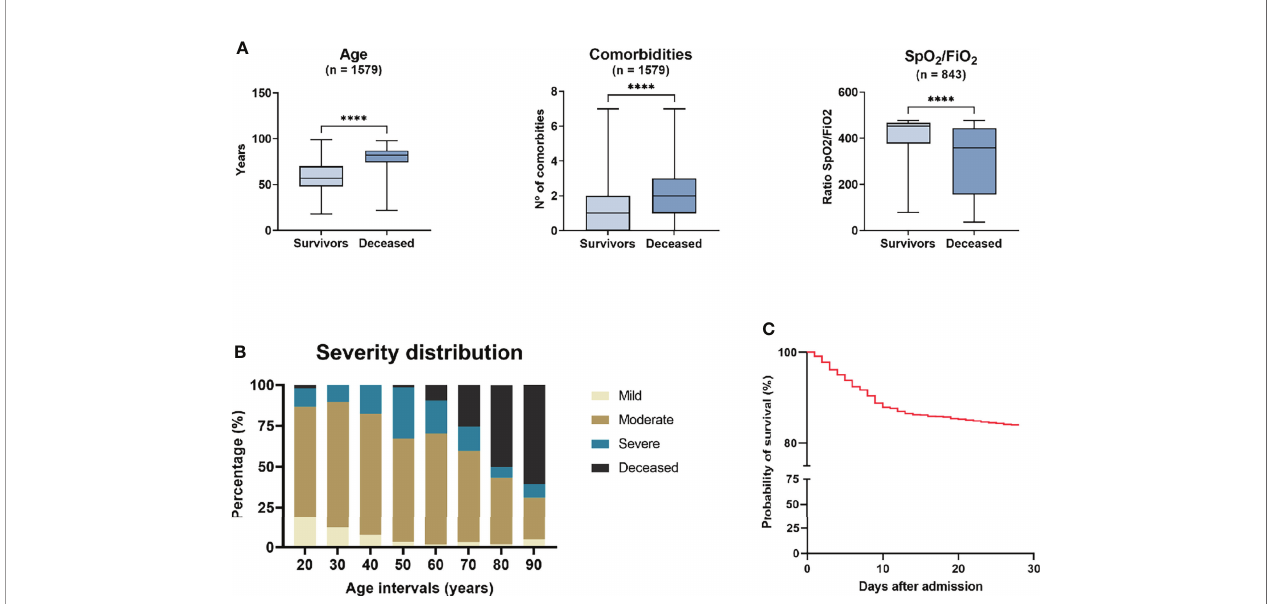
FIGURE 2 | The structure and outcomes of the Vall d ’ Hebron University Hospital cohort. (A) Left panel, age distribution of the survivors and that of the deceased is markedly different (median [IQR]: 62 years [50 – 75 years] vs. 82 years [74 – 87 years], p<0.001) as are comorbidities (central panel) and SpO2/FiO2 (right panel). (B) Distribution of the patients in the HUVH cohort among the four severity categories, based on the World Health Organization criteria (described in the Material and Methods section). The number of patients in the mild category is small (n=71) as only patients with bilateral pneumonia or severe associated pathologies were hospitalised during this period of the pandemic. (C) Survival after admission: this graph highlights mortality during the initial 10 days, with a high number of patients older than 80 years dying in the initial 3 – 4 days (see text “ Overall Clinical Features of HUVH cohort ” ). HUVH, Vall d ’ Hebron University Hospital ****p <